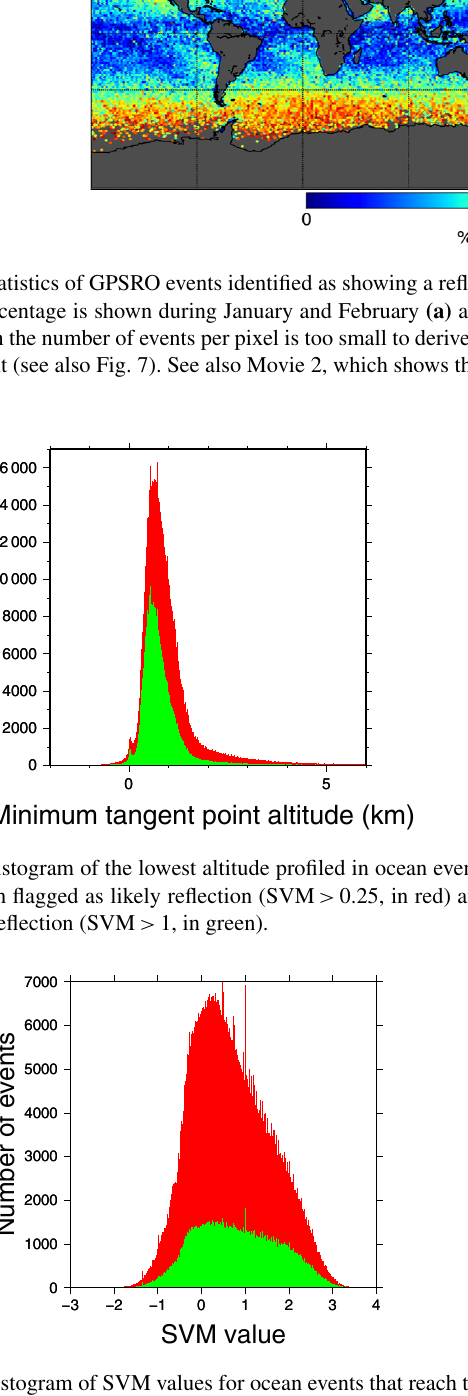
Figure 6. Histogram of SVM values for ocean events that reach the lowest kilometer of the troposphere ( H min < 1km, in red) and the lowest 500m ( H min < 0.5km, in